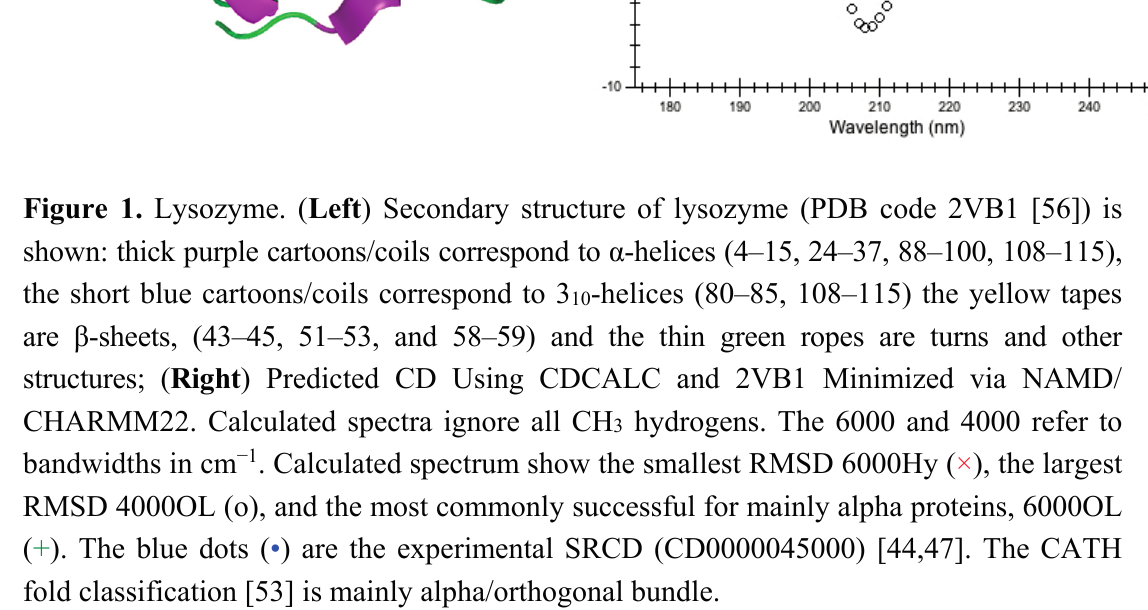
(+). The blue dots (•) are the experimental SRCD (CD0000045000) [44,47]. The